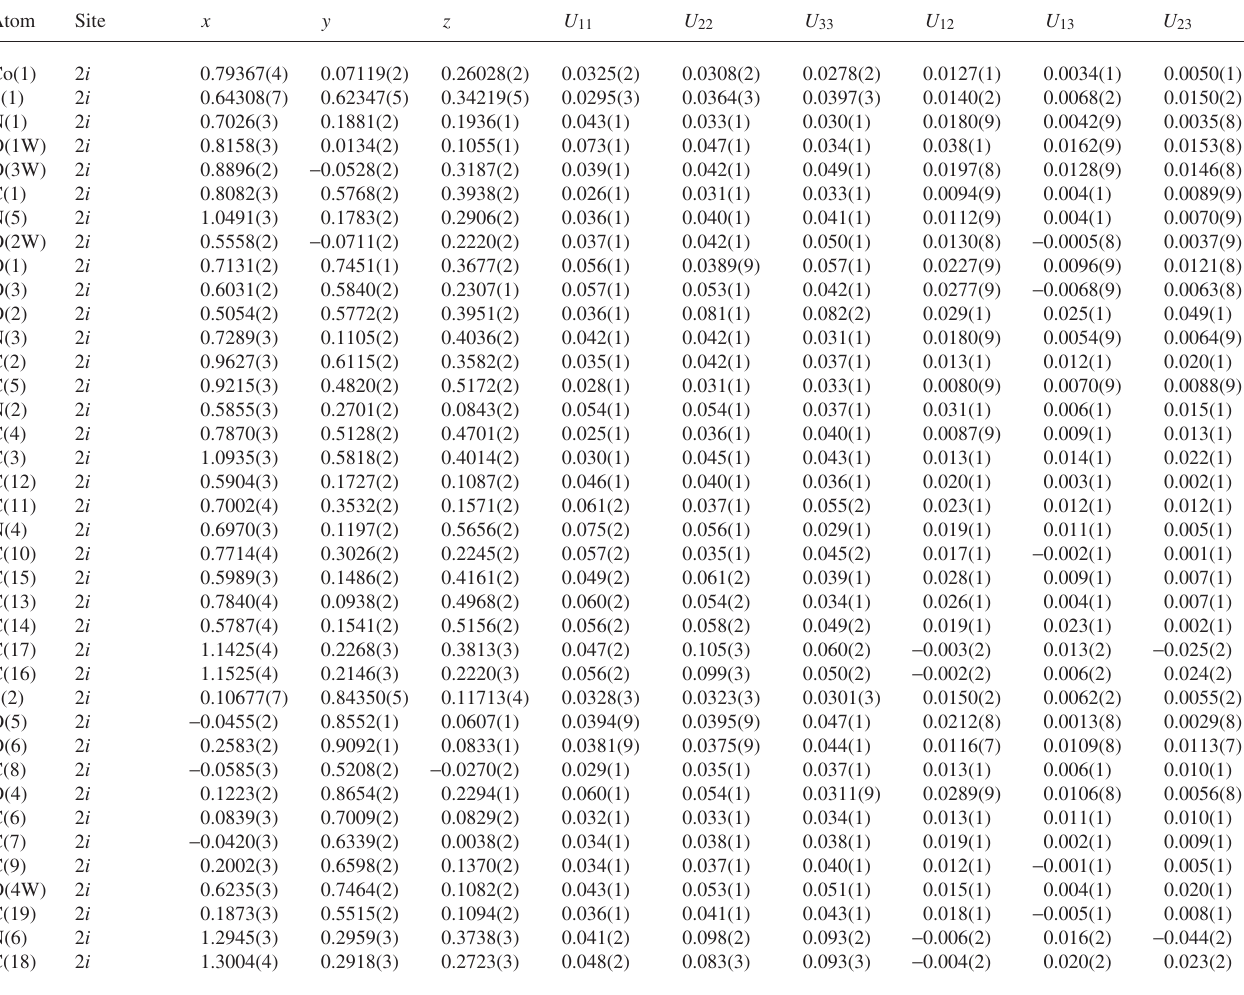
Table 3. Atomic coordinates and displacement parameters (in Å 2 ) .